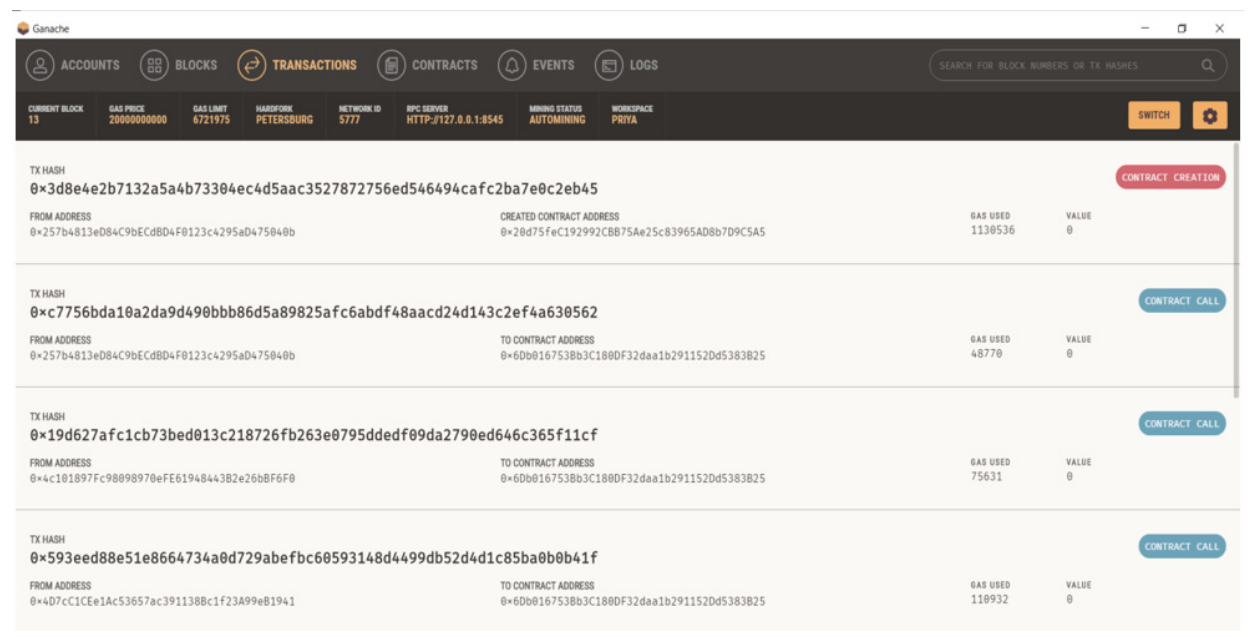
Figure 4. Transactions information in Ganache.